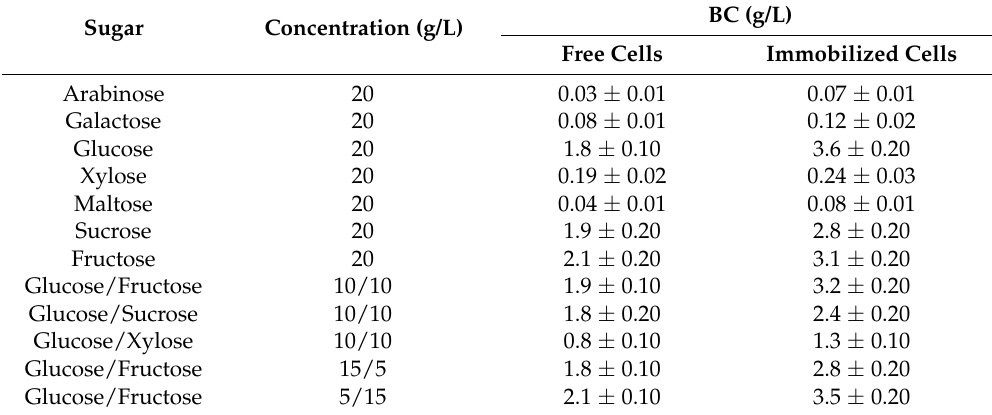
Table 2. Concentration of BC produced by free and immobilized cells of Komagataeibacter xylinum B-12429 in the media with different